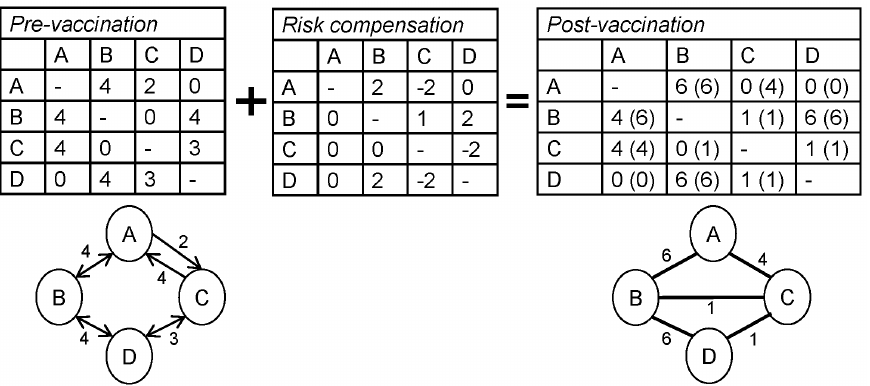
Figure 1. Illustration of procedure for constructing pre- and post-vaccination risk networks for comparison. Figure 1 displays a network of risk relationships among participants A, B, C and D. The corresponding adjacency matrixes are also presented. The values of the pre- and post-vaccination network ties represent frequency of HIV risk behavior, or the sum of three Likert scales on which participants rated the frequency of unprotected sex and frequency of needle and cooker sharing with the alter. Values in the risk compensation matrix represent the degree of behavior change anticipated to occur after HIV vaccination, with negative numbers representing a decrease in risk behavior, zeros representing no change, and positive numbers representing risk compensation. To construct the post-vaccination matrix, the risk compensation matrix was added to the pre- vaccination matrix. Also, Participant D reported that they would initiate a risk relationship with Participant B, so a tie was added and a one was entered in the corresponding cell of the post-vaccination matrix. Numbers in parentheses represent the symmetrized version of the network; the symmetrized version was used for analysis.